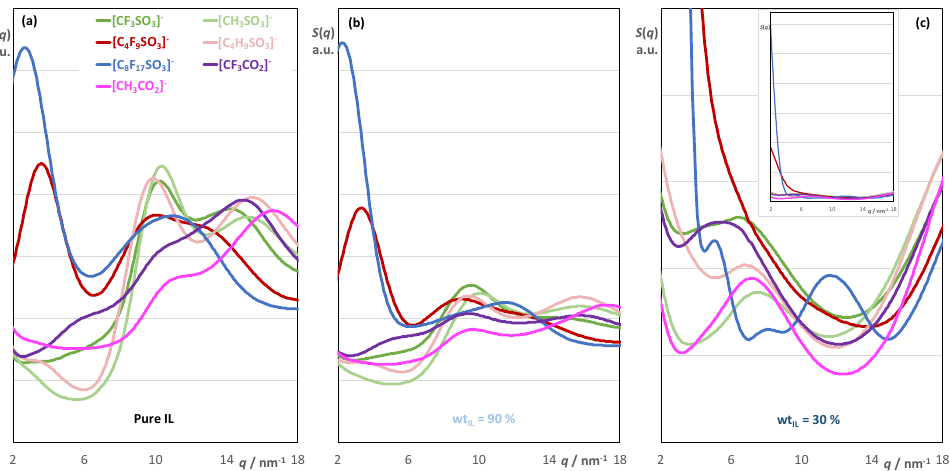
Figure 7. Structure factors calculated at 300 K for ( a ) pure ILs, ( b ) aqueous solutions with wt IL = 90% (X IL = 0.23–0.49), and ( c ) wt IL = 30% (X IL = 0.01–0.04). At higher water concentrations, wt IL = 0.3 (X IL = 0.01–0.04, Figure 7c), it is observed